Question: What type of chart is this?
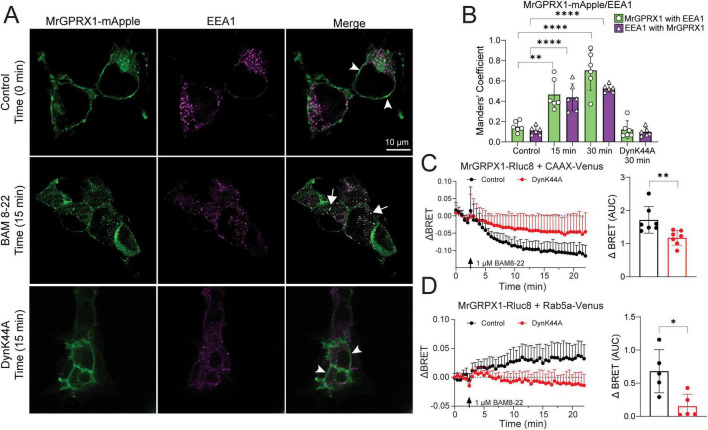
Answer: line